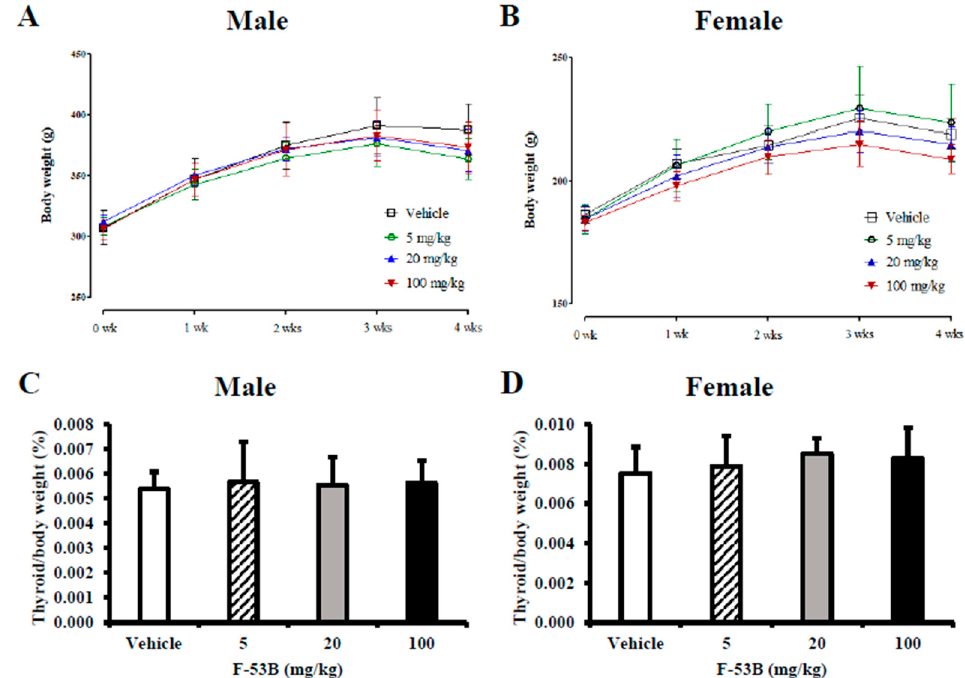
Figure 3. Body and relative organ weights after F-53B administration. Body weight changes after F-53B administration for 28 days in male ( A ) and female ( B ) rats. The thyroid / body weight ratios are shown for male ( C ) and female ( D ) rats. The data are displayed as the mean ± s.d. ( n = 7). For values that di ff er significantly as assessed by one-way analysis of variance and Dunnett’s test: * indicates p < 0.05 compared with the vehicle control group and ** indicates p < 0.01 compared with the vehicle control group.